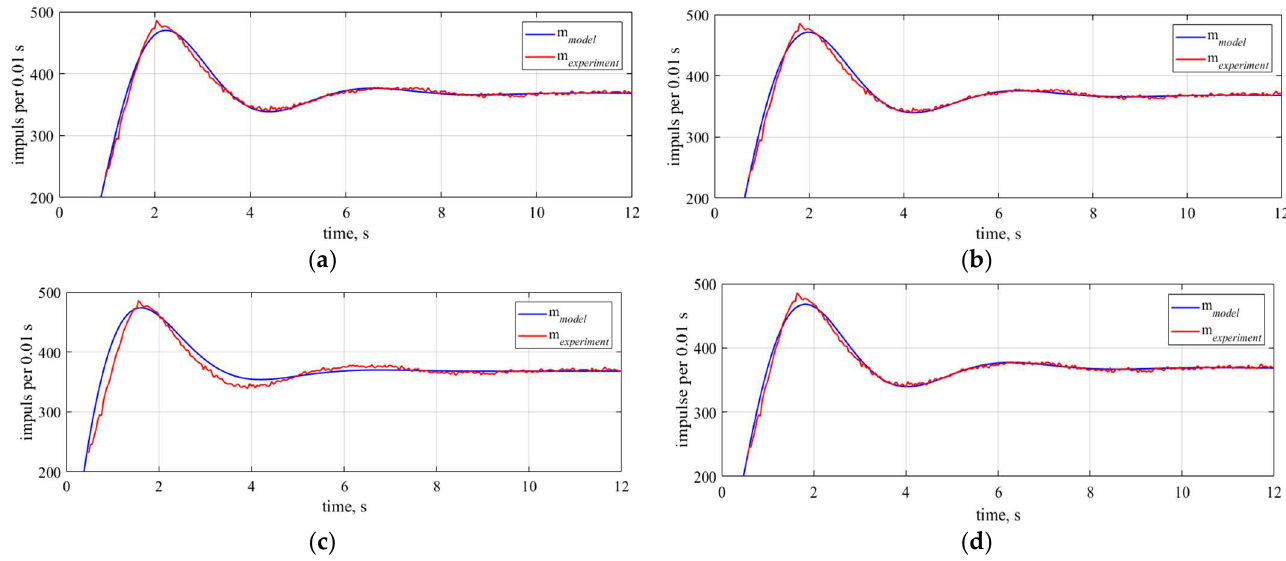
Figure 8. General view of the stand ( a ) and induction brake on a movable frame ( b ), controller 32F429IDISCOVERY ( c ), and Power Block with G4PH40UD ( d ). Comparison of experimental transient processes m experiment with calculated m model : ( a ) W co1 , ( b ) W co2 , ( c ) W co3 , ( d ) W co4.